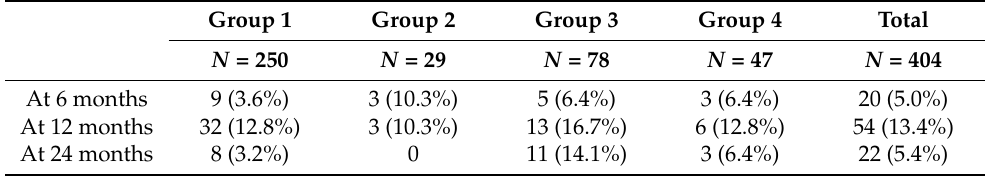
Table 5. Number of patients with PE